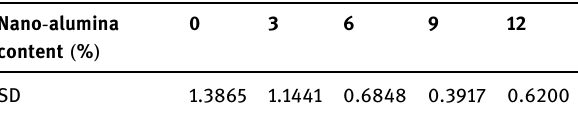
Table 6: Calculation results of bull ’ s - center distance with di ff erent nano - alumina contents Nano -